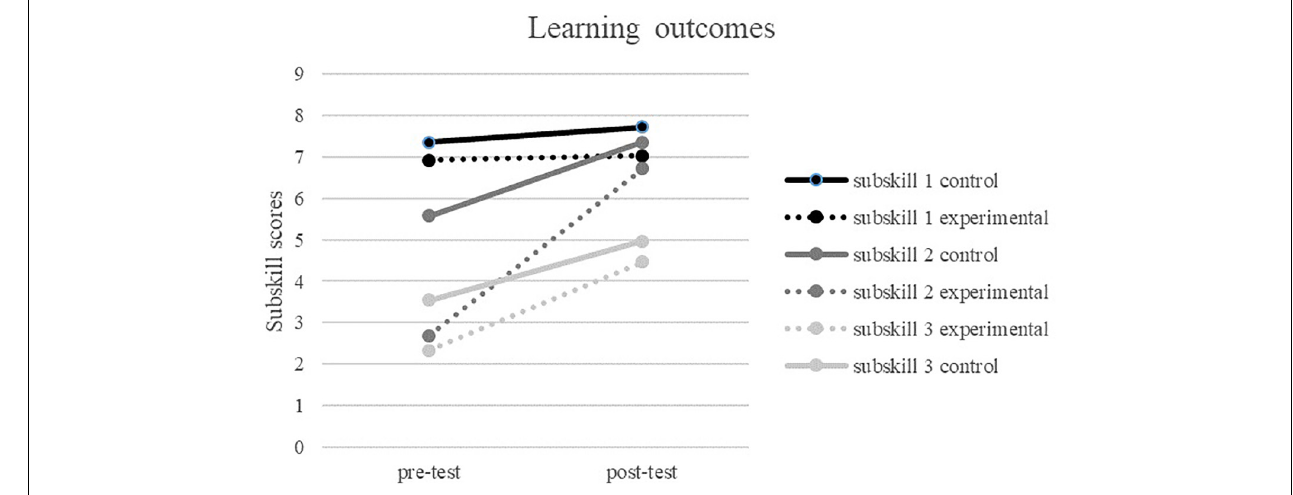
FIGURE 4 | Learning over the lessons per subskill indicating pre-test and post-test.